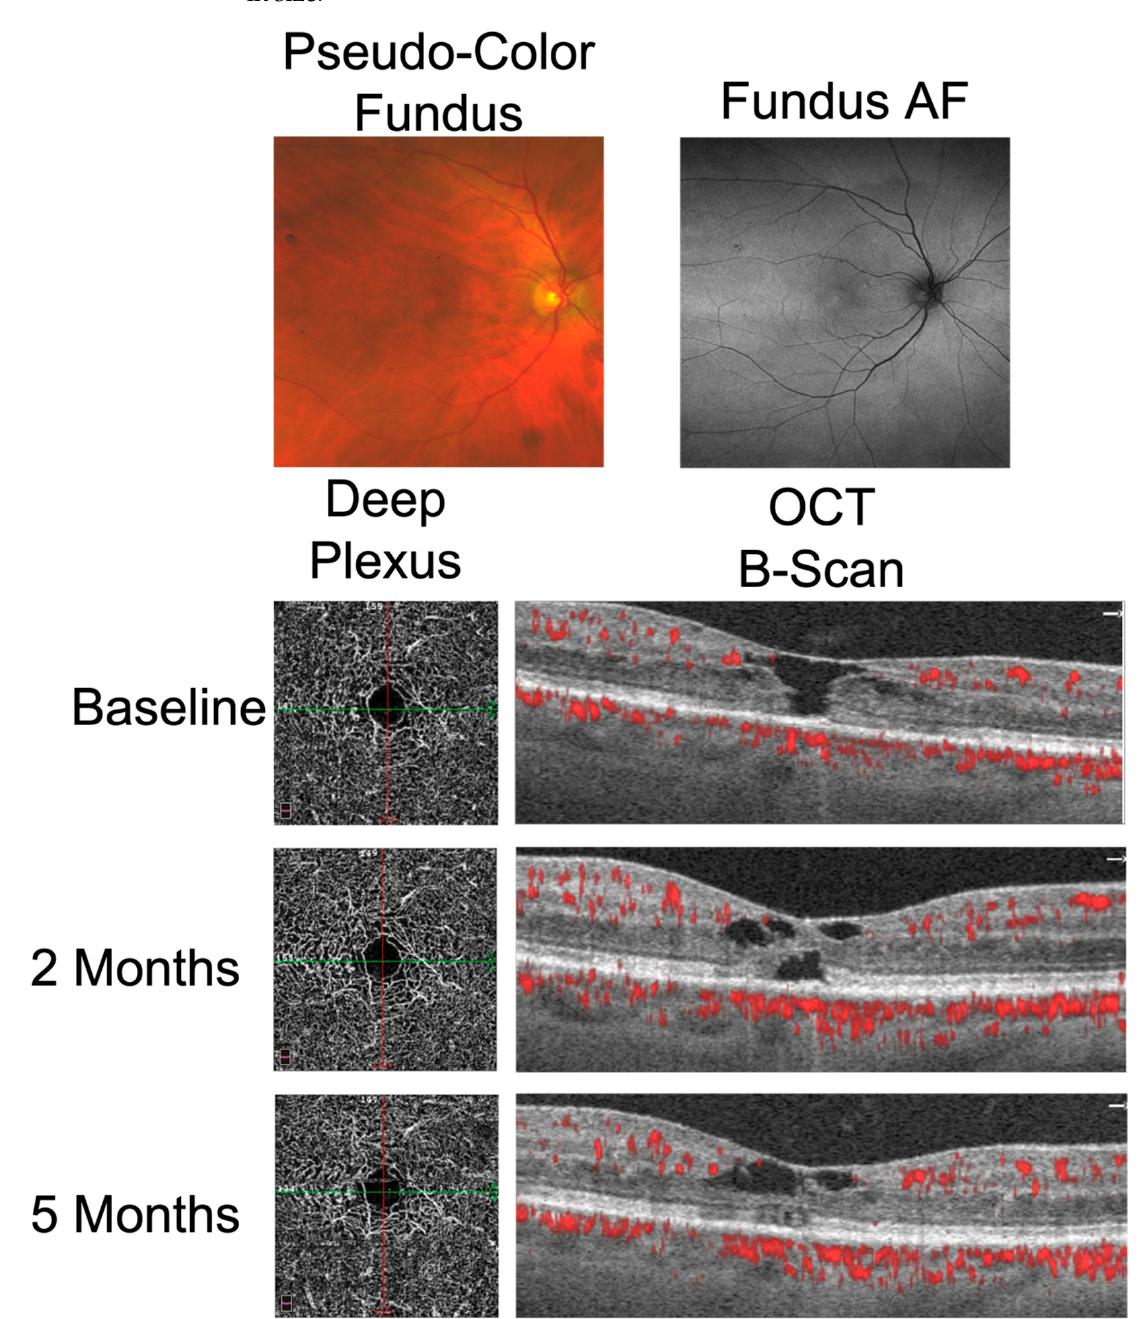
Figure 4. Closure of the outer retinal layers of the right eye following drop therapy in patient B with MacTel. Pseudo-color fundus imaging demonstrates subtle hypopigmentation in the temporal parafovea and fundus autofluorescence (AF) reveals a corresponding area of increased autofluores- cence. OCTA of the deep capillary plexus is shown at left, with B-scans shown at right. OCT B-Scans are taken through the central fovea, as shown by the green line through the deep capillary plexus vessel map. Patient B followed a drop therapy regimen consisting of prednisolone acetate four times per day, ketorolac four times per day, and dorzolamide three times per day for seven months in the right eye. Cavitations of the inner retina persisted after 8 months of drop therapy.